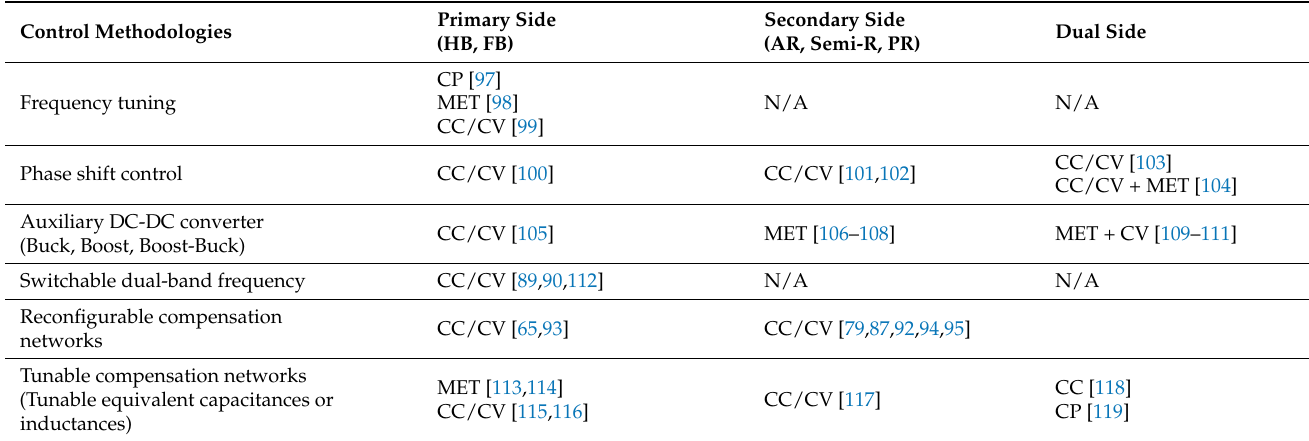
Figure 11. Category of control strategies in the IPT systems. Table 5. Summary of control methodologies for IPT